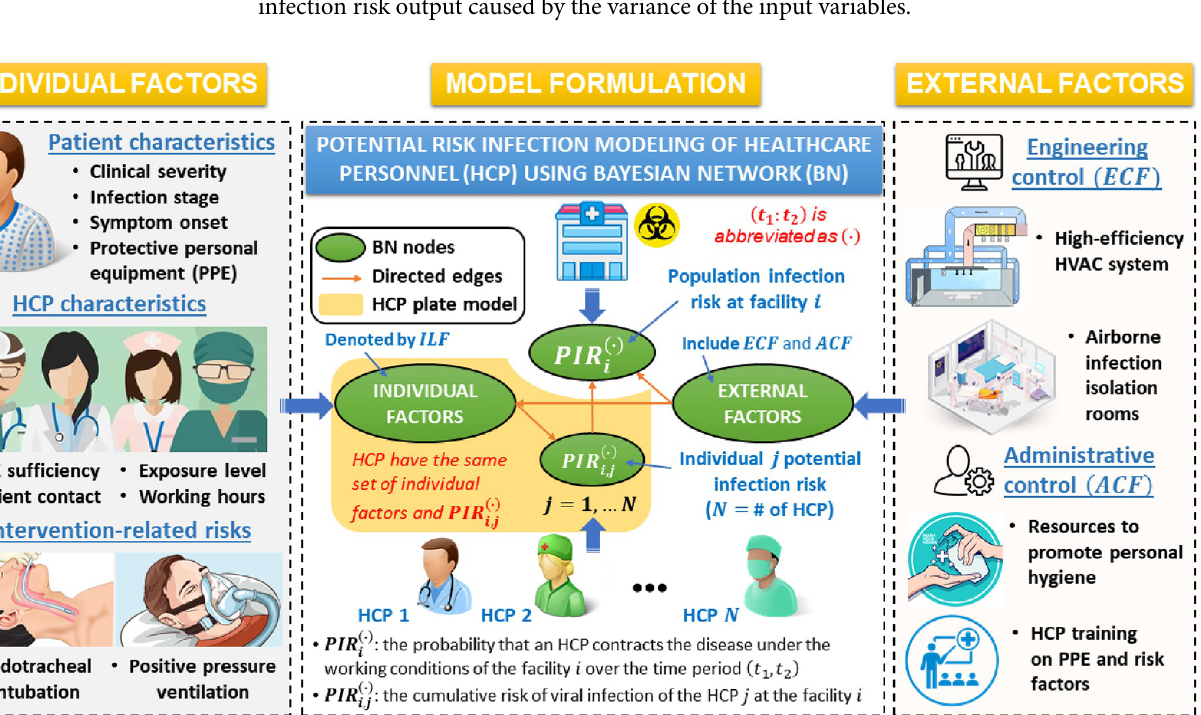
PLOS ONE | https://doi.org/10.1371/journal.pone.0272919 November21,